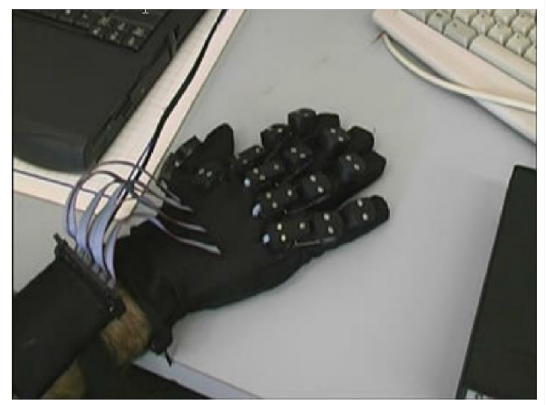
Figure 22. Depicts the Humanglove having 20 Hall effect sensors [1].